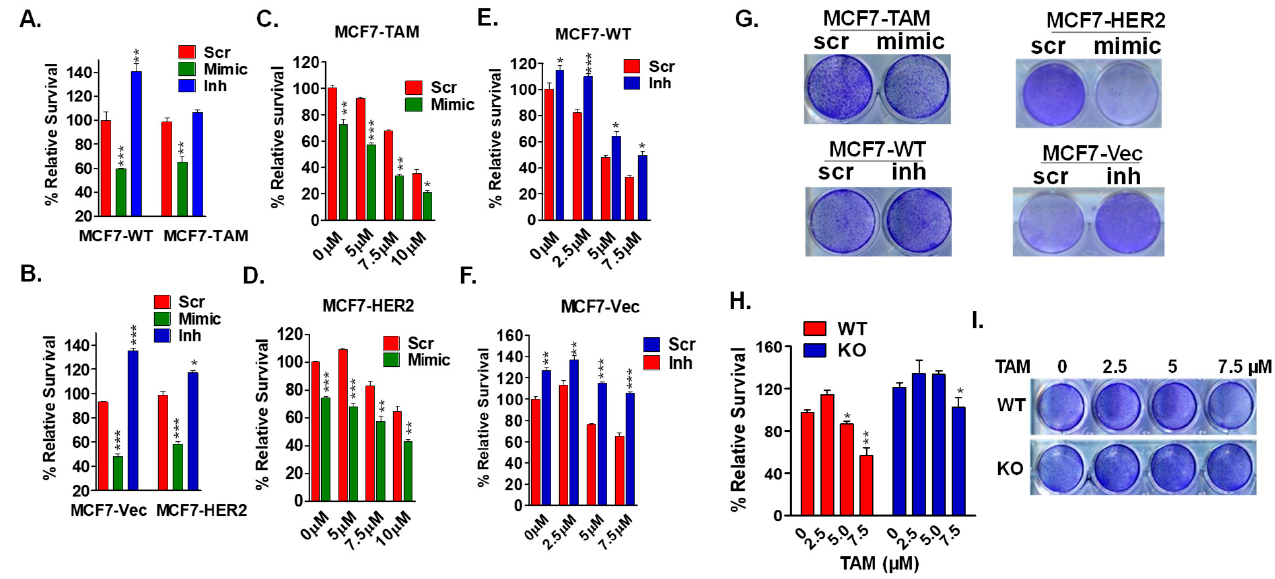
Figure 2. miR-489 restoration overcomes acquired and de novo tamoxifen resistance. ( A , B ) Effect of miR-489 modulation on proliferation of two pairs of tamoxifen-resistant cell lines. Cells were transfected with 28 nM of Scramble siRNA, miR-489 mimic, and miR-489 inhibitor for 72 h, followed by an MTT-based viability assay. ( C , D ) miR-489 restoration sensitized MCF7-TAM and MCF7-HER2 cell lines to tamoxifen. Scramble siRNA or the miR-489 mimic were transfected with or without tamoxifen for 72 h, followed by an MTT-based viability assay. ( E , F ) Depletion of miR-489 promoted tamoxifen resistance in tamoxifen-sensitive cell lines MCF7-TAM and MCF7-HER2. ( G ) Colony formation assay showing that miR-489 modulated tamoxifen resistance. Cells were treated with indicated microRNA mimics or inhibitors with or without tamoxifen for 72 h, followed by a colony formation assay for 7–10 days. ( H , I ) miR-489 knockout conferred tamoxifen resistance. WT and KO T47D cells were treated with an indicated concentration of tamoxifen, and viability was examined using MTT ( H ) and colony formation ( I ) assays. * p < 0.05; ** p < 0.01; *** p < 0.001. Data are representative of three independent